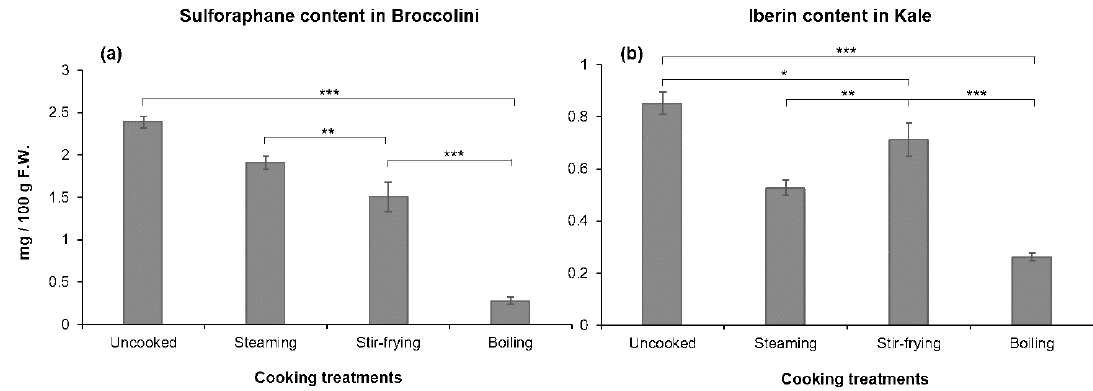
Figure 1. Isothiocyanate content in vegetables after cooking treatments: ( a ) sulforaphane content in broccolini samples; ( b ) iberin content in kale samples. F.W.: fresh weight. Mean values ( n = 3) ± SD. Levels of statistically significant di ff erences among treatments are the following: no di ff erences